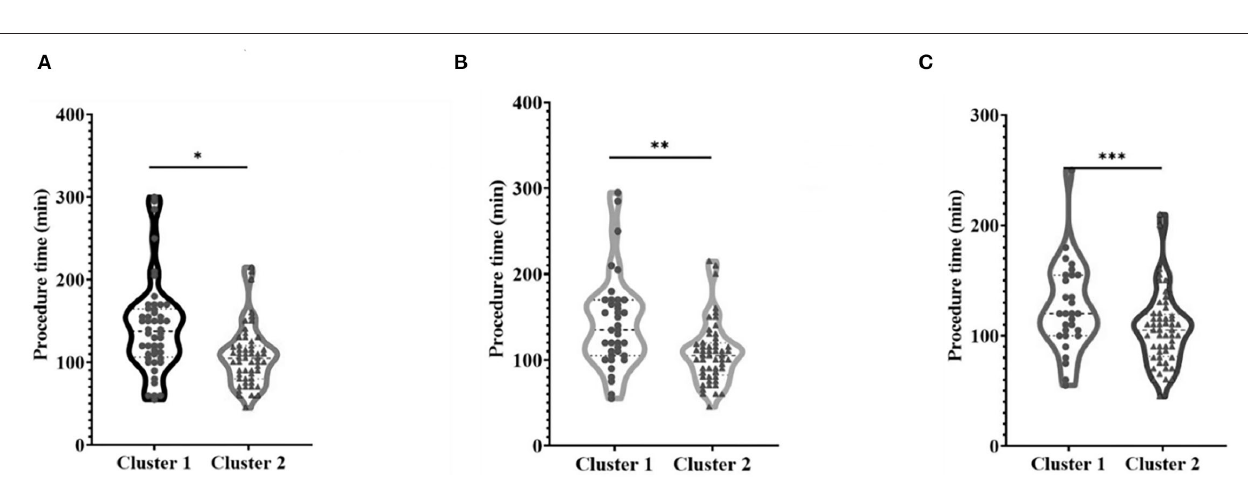
FIGURE 5 | Comparison of procedure time between the two clusters. (A) Procedure time of the two clusters of 103 cases, * P < 0.001; (B) procedure time of the two clusters excluding patients with technique failure, ** P = 0.001; (C) the procedure time of each cluster excluded patients with technique failure and those recanalized with sharp needles, *** P =